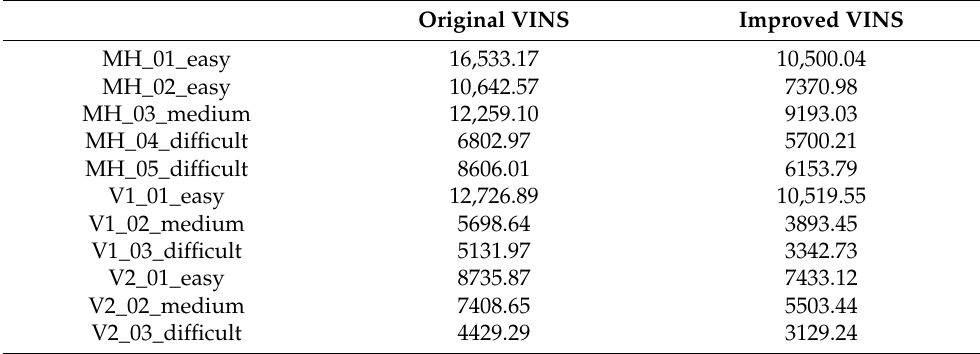
Table 6. Compare the marginalization speed between the original algorithm and the improved algorithm in the EuRoC dataset. (Unit: ms).